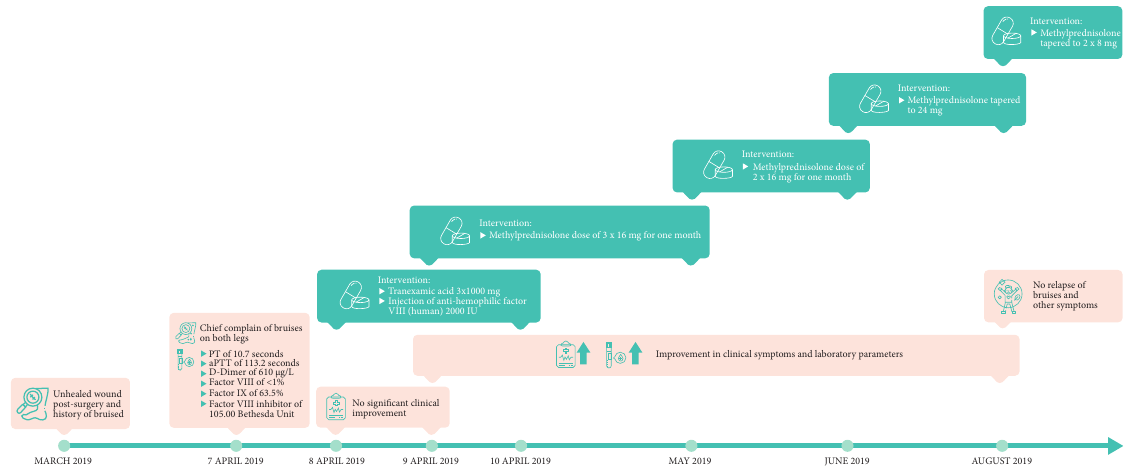
Figure 1: Timeline of events and interventions for case